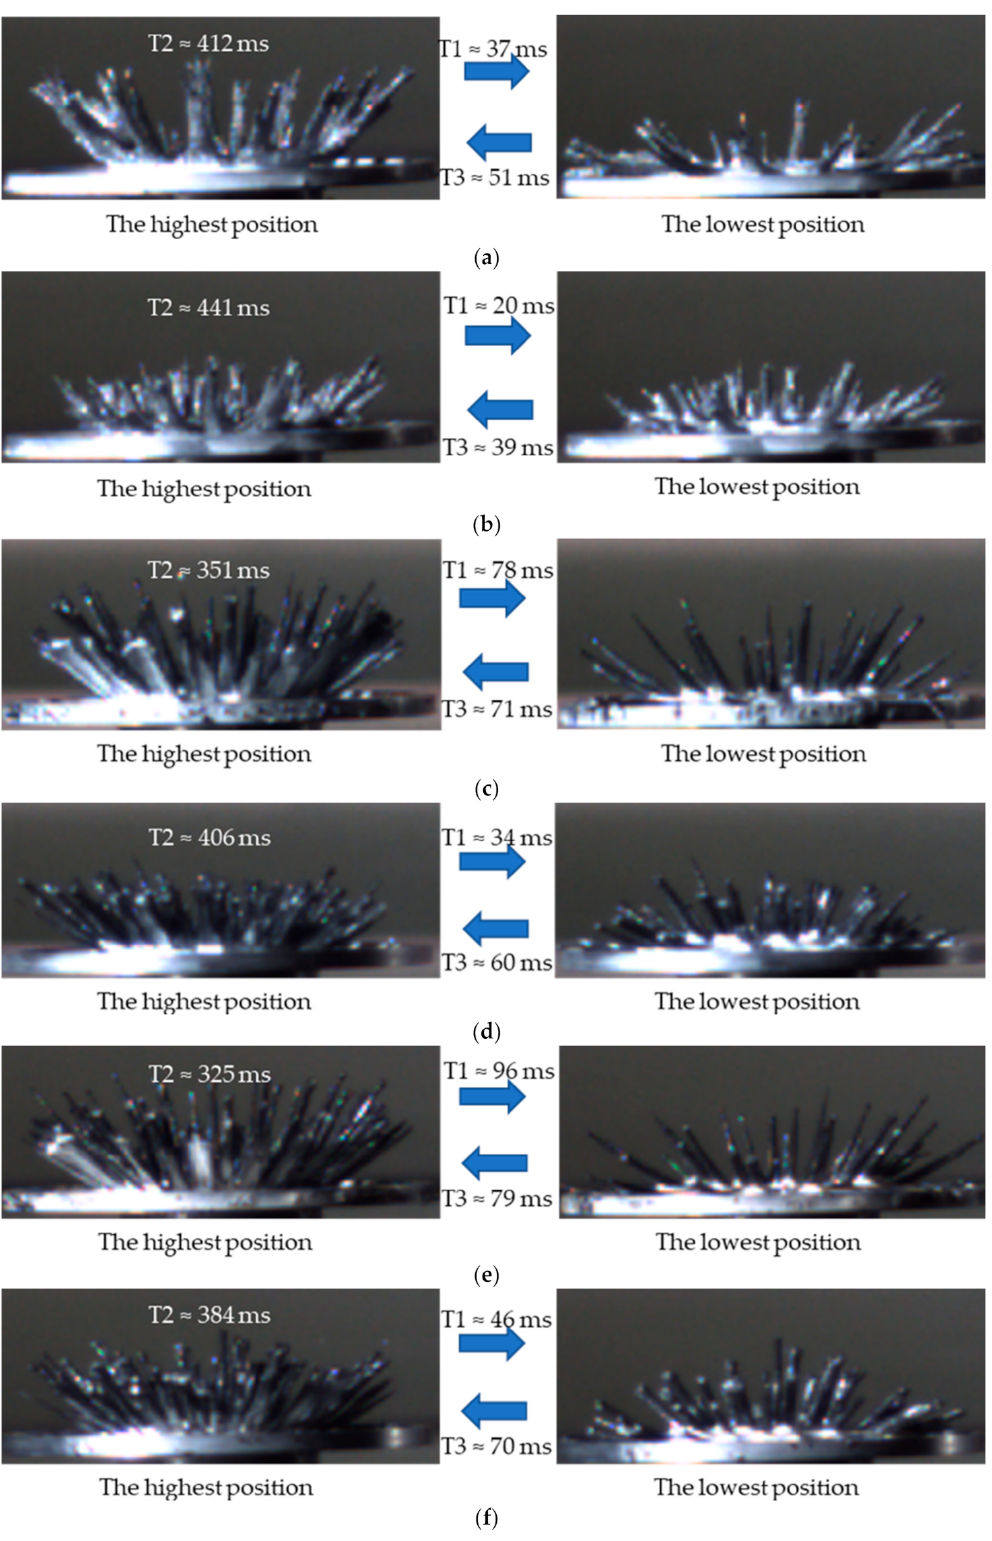
Figure 5. The lowest position and the highest position in the fluctuation period of the magnetic cluster. ( a ) Sin-AC, 330 µ m; ( b ) S-AC, 330 µ m; ( c ) Sin-AC, 149 µ m; ( d ) S-AC, 149 µ m; ( e ) Sin-AC, 75 µ m; ( f ) S-AC, 75 µ